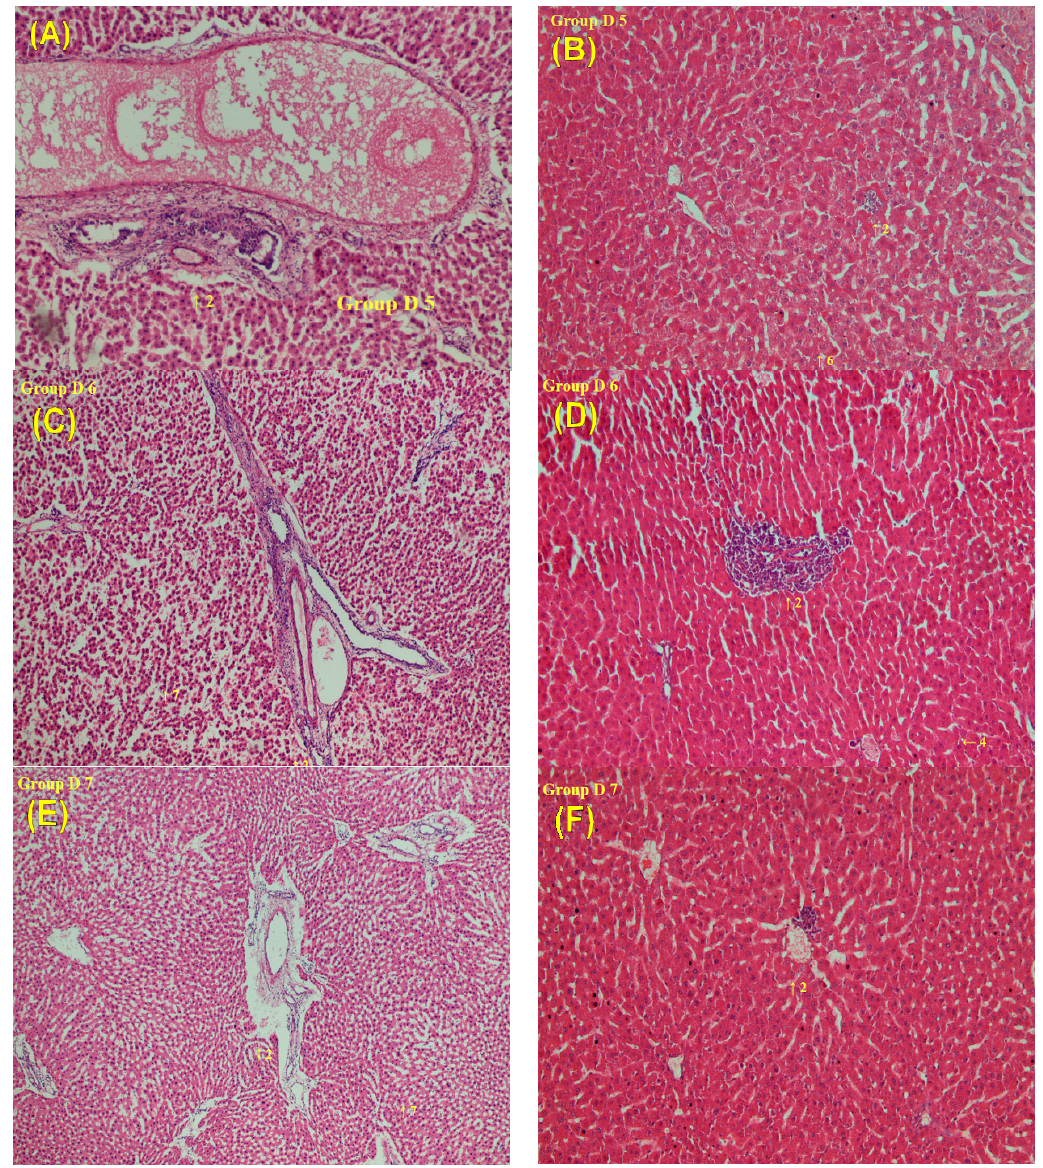
Figure 5. Histopathological analyses of the rat livers from groups subjected to repeated administrations. ( A , B ) Group D5: repeated treatment with sorafenib (10 mg/kg) for two weeks; ( C , D ) Group D6: repeated treatment with the combination of LDXGT formulation (1 g/kg/day, p.o.) and sorafenib (10 mg/kg, p.o.) for two weeks; ( E , F ) Group D7: repeated treatment with the combination of LDXGT formulation (2 g/kg/day, p.o.) and sorafenib (10 mg/kg, p.o.) for two weeks. 1: focal inflammation; 2: portal inflammation; 3: focal hemorrhage and congestion; 4: focal lytic necrosis; 5: apoptosis; 6: liver cell degeneration; 7: intercellular cohesion broken.